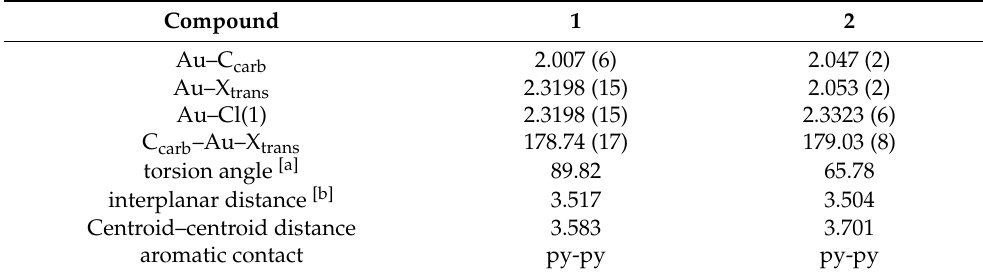
Figure 4. Solid structure of complex 2 with 50% probability ellipsoids. Hydrogen atoms and acetone molecule are omitted for clarity. Selected bond lengths (Å) and angles (°): Au(1)-C(1) 2.047(2) (C(1)-Au(1)-Cl(1) 89.18(6), C(18)-Au(1)-C(1) 88.27(8), C(18)-Au(1)-C(24) 91.06(9), C(24)-Au(1)-Cl(1) 91.51(6). Table 1. Selected Bond Lengths (Å), Angles (°), Torsion Angles (°), Interplanar Distance (Å) and Centroid–Centroid Distance for Complexes 1 and 2 .